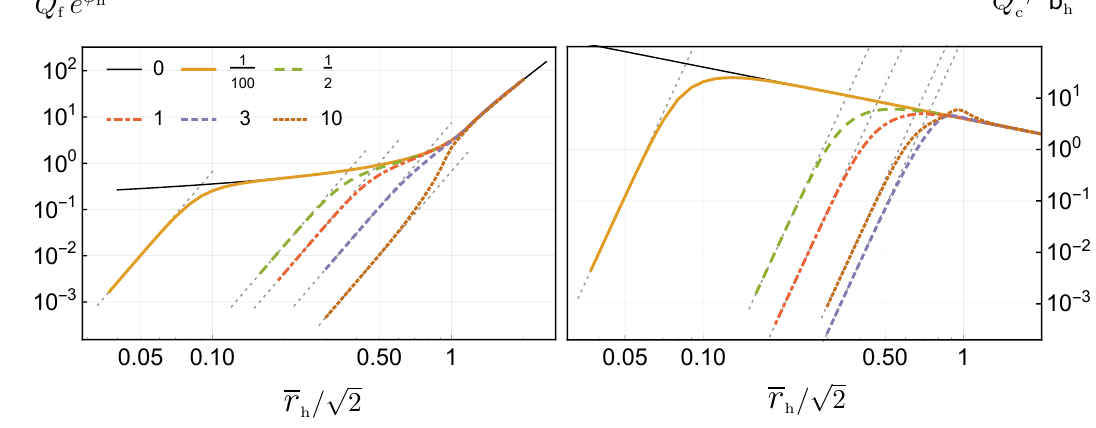
p 2 N (given in the q